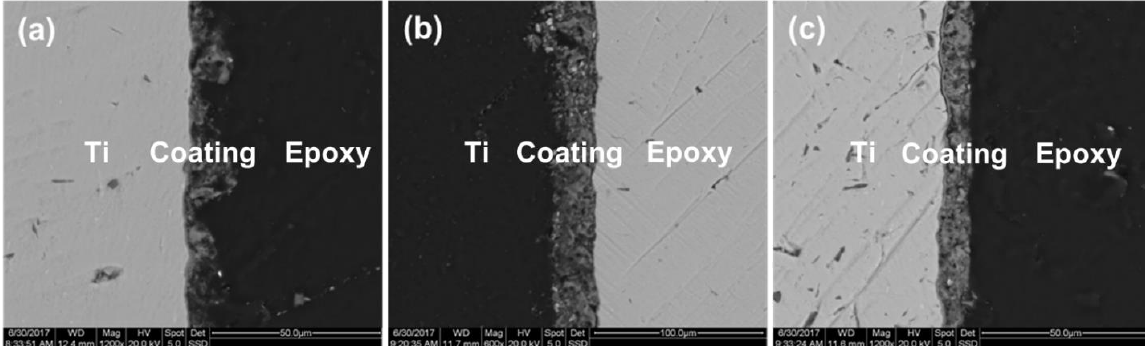
Figure 5. Cross-section SEM images of the prepared coating by micro-arc oxidation with different time: ( a ) MAO-1 coating, ( b ) MAO-2 coating, and ( c ) MAO-2 coating after its surface thin layer was ground off.